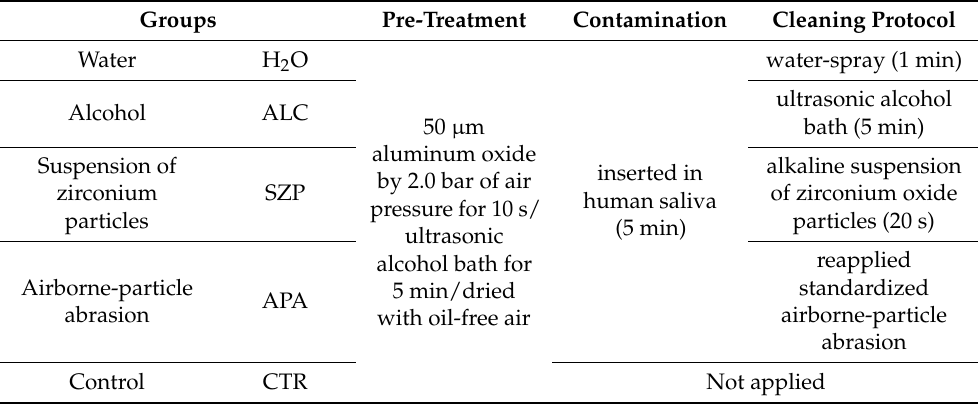
Table 1. Group identification and respective cleaning protocol applied.